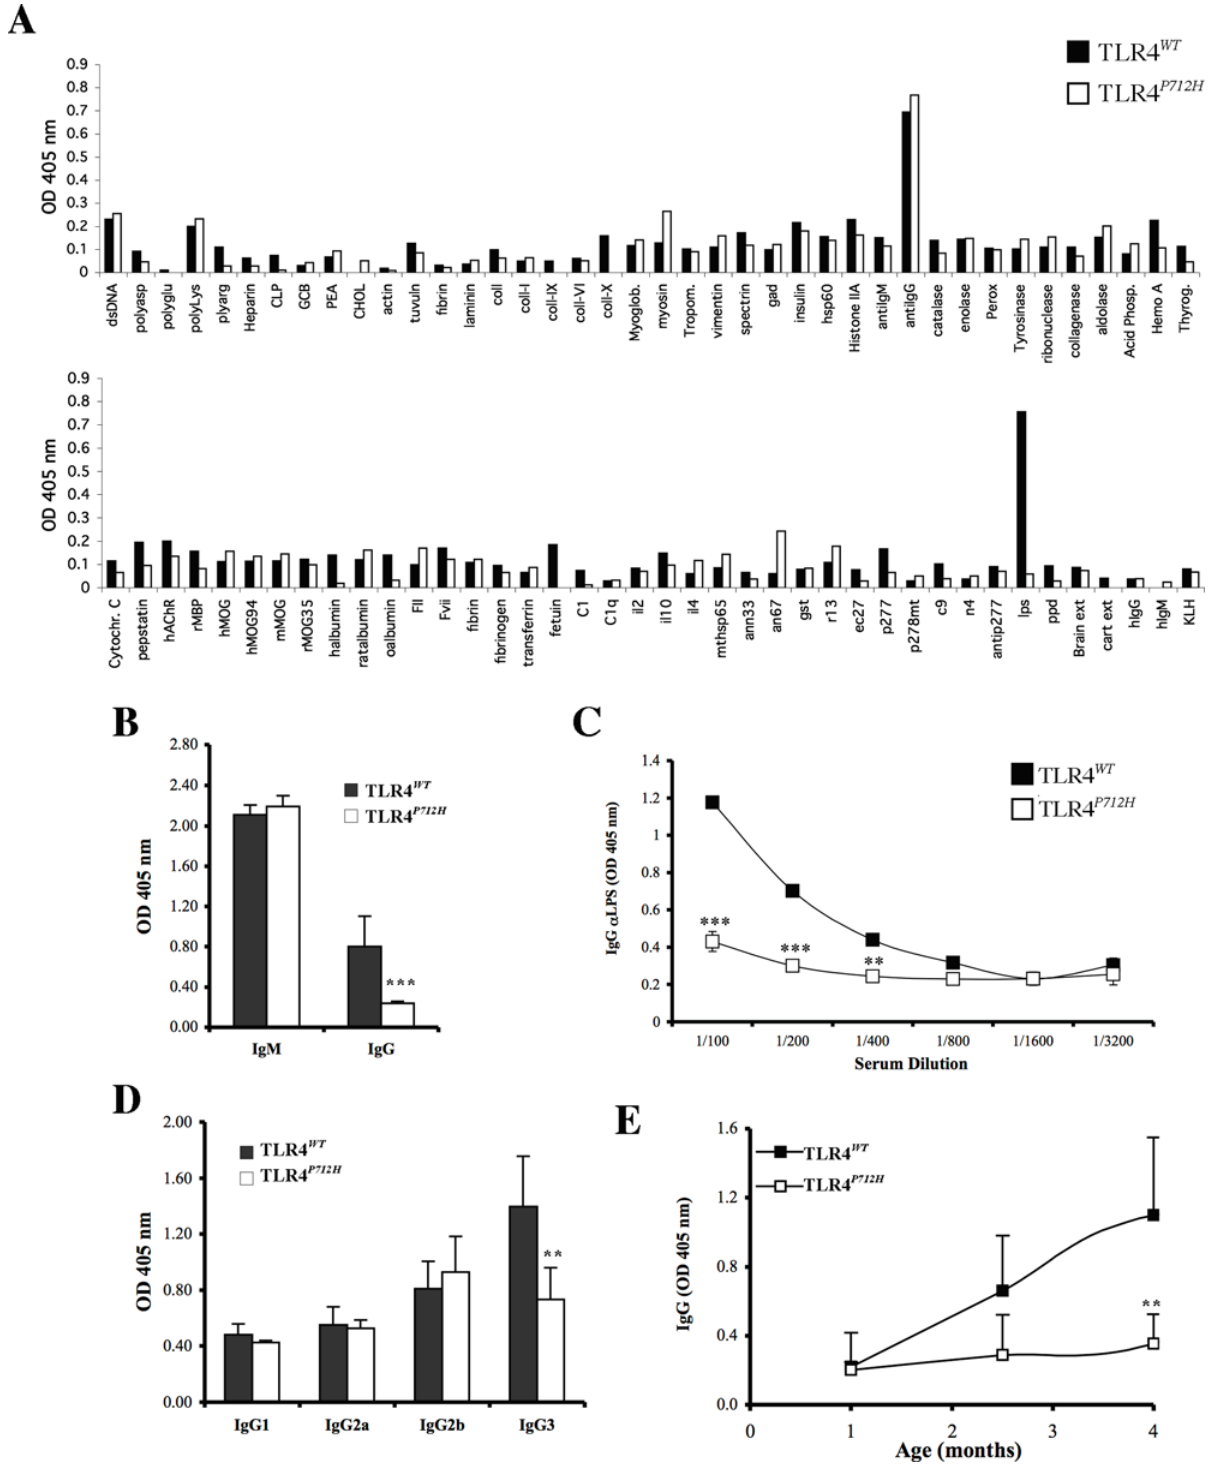
Figure 1. Natural IgG antibodies to LPS are not detectable in TLR4 P712H mice. A. IgG reactivity in pooled blood samples from non- immunized TLR4 WT and TLR4 P712H mice. B. IgM and IgG antibodies to LPS in individual TLR4 WT and TLR4 P712H mice (n=5, *** P , 0.001 when compared to TLR4 WT mice). C. Titration of spontaneous IgG antibodies to LPS in TLR4 WT and TLR4 P712H mice (n=5 per group, ** P , 0.01 and *** P , 0.001 when compared to TLR4 WT mice). D. IgG subclass of antibodies to LPS in individual TLR4 WT and TLR4 P712H mice (n=5, ** P , 0.01 when compared to TLR4 WT mice). E. Time course of the induction of IgG3 antibodies to LPS (n=6 per group, ** P , 0.01 when compared to TLR4 WT mice).